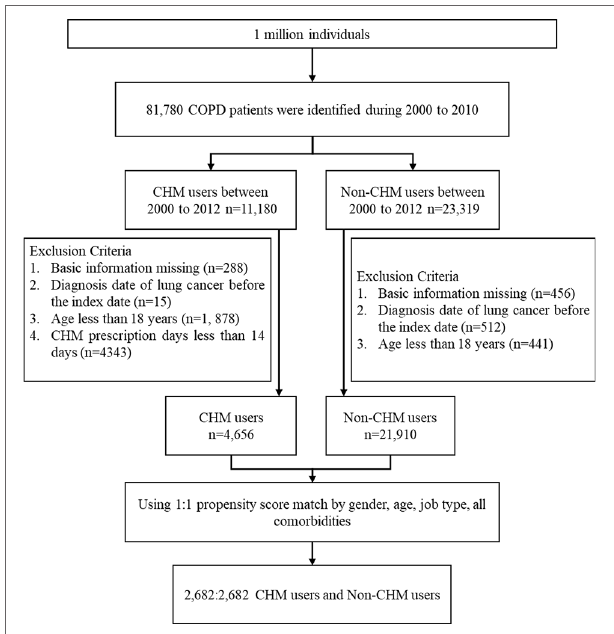
FIGURE 1 | Flow chart of study cases identified from 1 million insured individuals in Taiwan between 2000 and